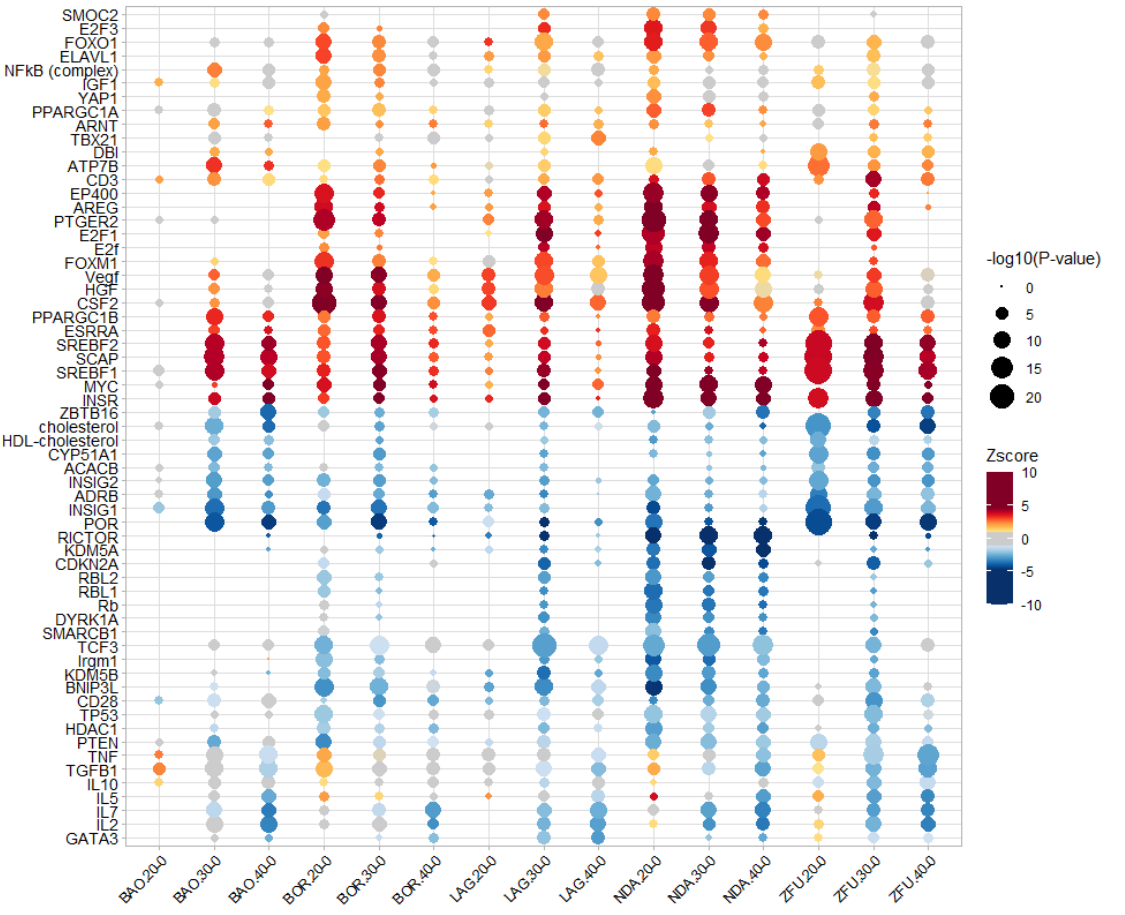
Figure 8 - Plot of 61 significantly enriched upstream regulators inferred as activated or inhibited in function of the within-breed contrasts. The 15 within-breeds contrasts are shown on the abscissa and the significantly enriched diseases and functions on the ordinate. The size of the circles is inversely proportional to the P-value of the upstream regulator in the aforementioned contrast. The color gradient of the circle corresponds to the Z-score range, i.e. warm color gradient for positive Z-score>1, cold color gradient for negative Z-score<-1, and gray color gradient for Z-scores ranging between -1 and